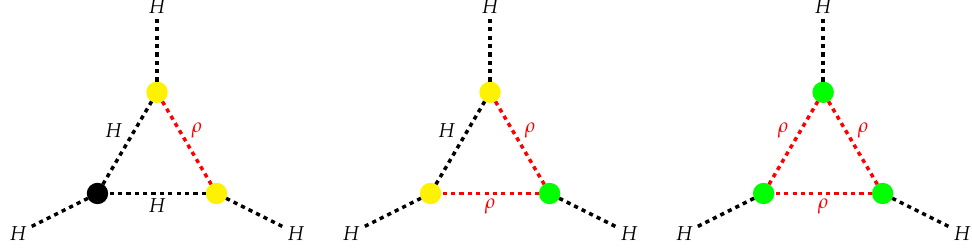
Figure 2. One-loop corrections to SM triple Higgs coupling induced by the existence of an extra scalar singlet. In Equation (15), the correction ∆ λ HHH is